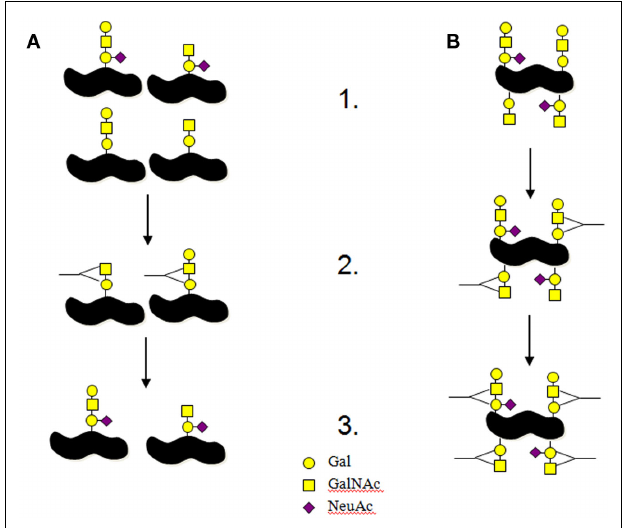
FIGURE 2 | Interactions between bacterial antigens and host immune system. (A) This is the normal process for the interactions between host immune systems and pathogenic bacteria. (1) A portion of the bacterial colony produces different antigens on their surfaces. (2) The immune system targets the surface structures that are presented in a part of the population resulting in other antigens being selected to remain. In this example antibodies are produced to non-sialylated LOS structures. (3) The antigens not targeted by the immune system are allowed to expand causing the infection. (B) This is the model we think is happening for C. jejuni LOS. (1) Each bacterium produces all potential surface antigens in different concentrations. (2) The immune system targets the surface structures that are presented in the population resulting antibody production against a portion of the surface antigens. In this example antibodies are produced to non-sialylated LOS structures. (3) The antigens not targeted by antibodies are still present on the targeted bacteria resulting in the increased likelihood of producing antibodies to those other LOS antigens. If the host has a defect in the mechanisms of ensuring antibodies are not produced against self then C. jejuni producing multiple antigens per bacteria offers a greater risk for the production of anti-self